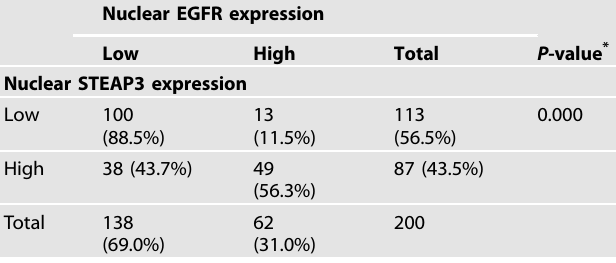
Table 3. Correlation between nuclear expression of STEAP3 and EGFR in hepatocellular carcinomas. Nuclear EGFR